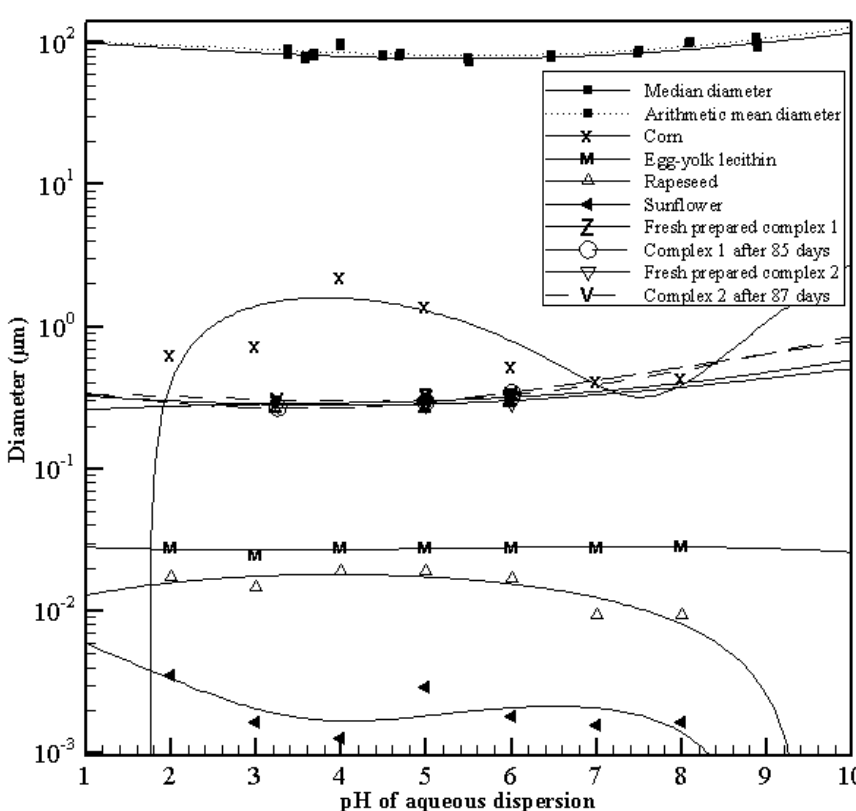
Figure 10: Average drop diameters of the arithmetic mean and median diameter for O/W emulsions as a function of pH for freshly prepared emulsions using batch emulsion [20, 26,